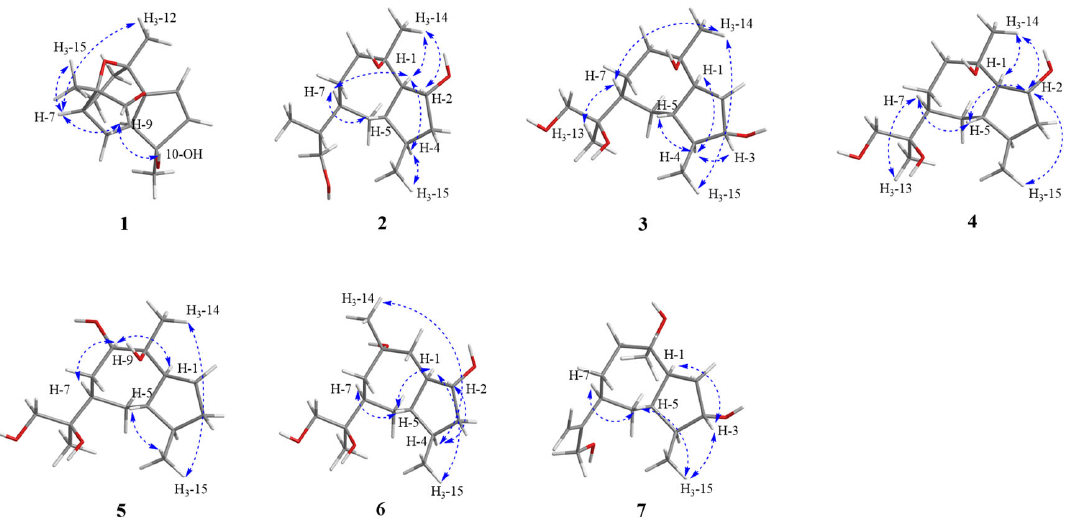
Figure 3. Key ROESY correlations of compounds 1 – 7 .